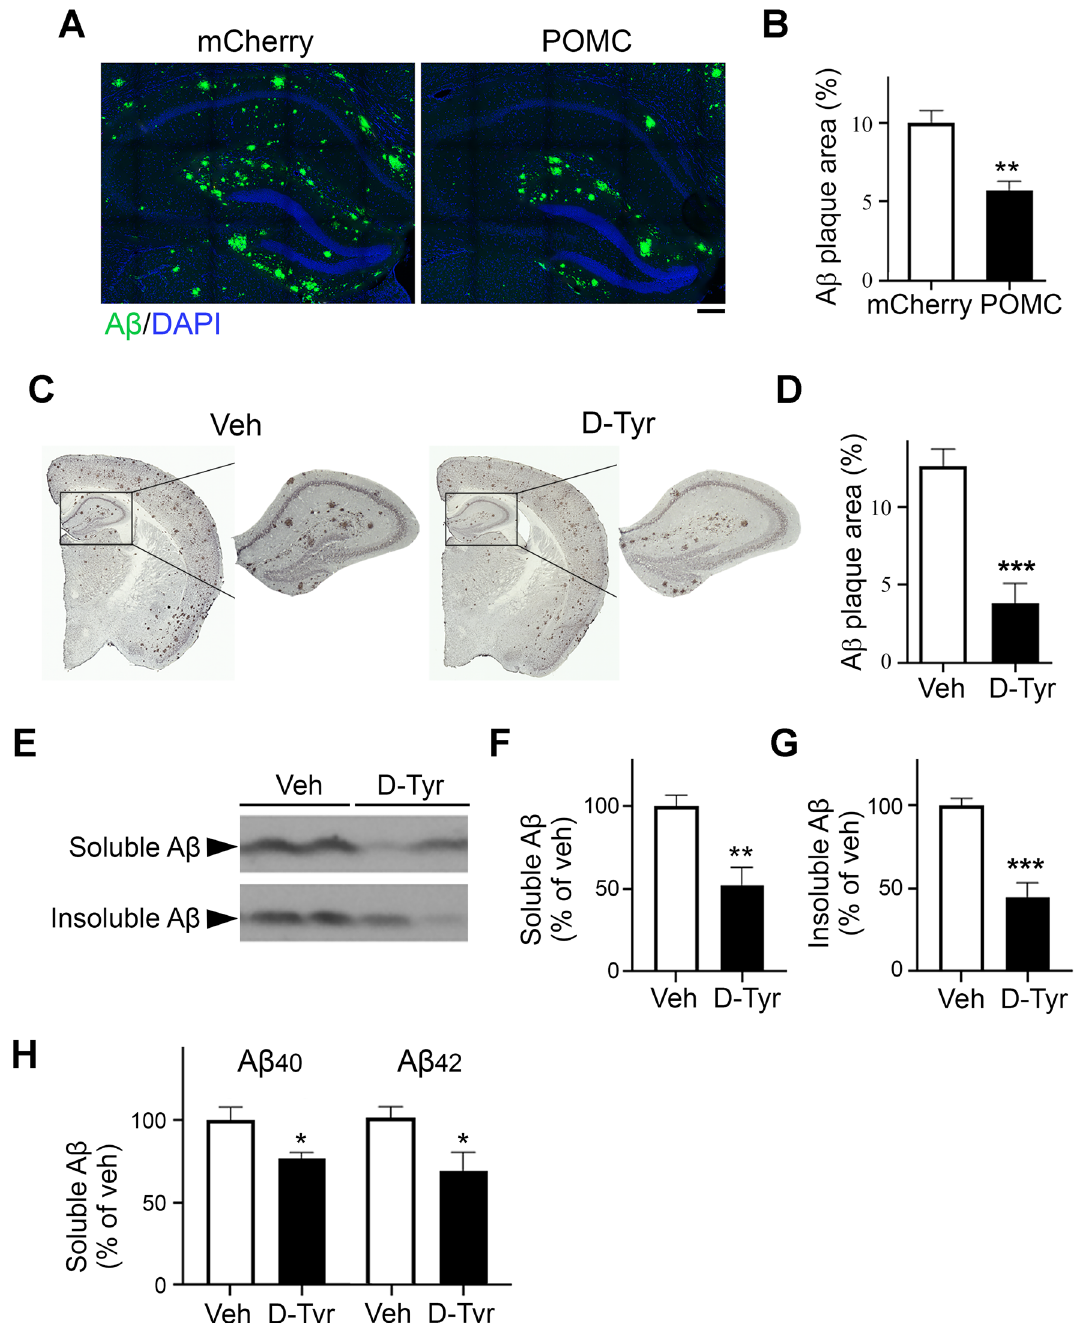
Figure 1. Activation of POMC/MCR signaling ameliorates amyloid pathology in the hippocampus in APP/PS1 mice. ( A , B ) The restoration of POMC expression in the CA3 region reduces the amyloid plaque area in the hippocampus in APP/PS1 mice. Representative fluorescence micrographs ( A ) and quantification ( B ) of 6E10-stained amyloid plaques in the hippocampus on coronal brain sections of APP/PS1 mice following intrahippocampal co-injection of Cre-dependent AAV-POMC-Cre/AAV-DIO-POMC (POMC) versus AAV-POMC-Cre and AAV-DIO-mCherry (mCherry) as a control ( n = 5 mice per group, 3 sections per mouse at 100–150-µm intervals). Amyloid plaques are shown in green, and nuclei are shown in blue. Scale bar = 100 µm. ( C , D ) Chronic d-Tyr administration reduced amyloid plaque deposition in APP/PS1 mice. Representative images ( C ) and quantification ( D ) of 6E10- stained amyloid plaques in the hippocampus on coronal brain sections of APP/PS1 mice following treatment with chronic d-Tyr versus control (Veh) ( n = 8–9 mice per group, 4 sections per mouse at 30-µm intervals). Rectangles denote the hippocampal area in the insets. Scale bar = 1 mm. ( E – G ) Chronic d-Tyr administration reduced soluble and insoluble Aβ contents. Representative western blot ( E ) and quantification of soluble ( F ) and insoluble ( G ) Aβ levels in hippocampal homogenates from APP/PS1 mice ( n = 8–9 mice per group). Full-length blots are presented at the end of Supplemental Information. As the blots were cut prior to hybridization with antibodies, membrane edges were outlined with solid black lines. ( H ) Quantitative assessment (i.e., ELISA) of the relative levels of Aβ x–40 and Aβ x–42 isomers in the soluble fraction from the hippocampus of APP/PS1 mice ( n = 4–5 mice per group). Data are the mean ± SEM of all mice from each group examined (* p < 0.05, ** p < 0.01, *** p < 0.001 for chronic d-Tyr vs. Veh or POMC vs. mCherry injection; Student’s